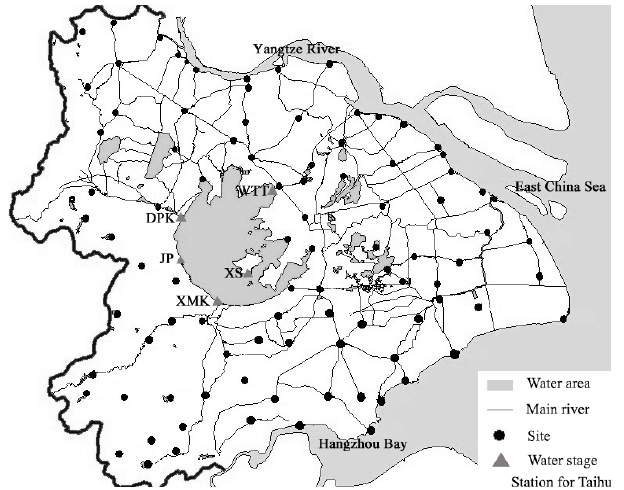
Figure 2. Location of study area and hydrometric stations